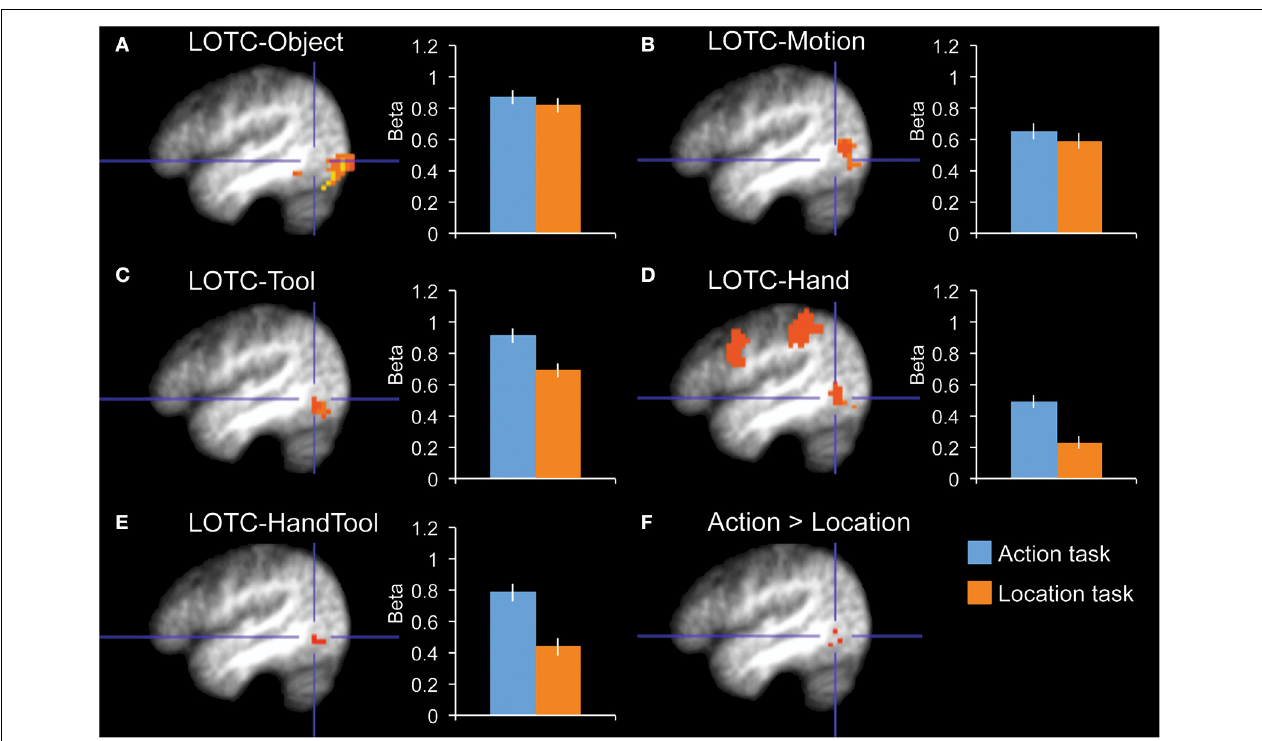
FIGURE 2 | fMRI results in functionally localized regions in left lateral occipitotemporal cortex. Bar graphs indicate mean activity (Beta weights) in the displayed ROIs during the action (blue) and location (orange) tasks of the main experiment. (A) LOTC-Object (intact > scrambled objects), (B) LOTC-Motion (moving > static dots), (C) LOTC-Tool (tools > animals), (D) LOTC-Hand (hands > animals), (E) LOTC-HandTool (tools > animals AND